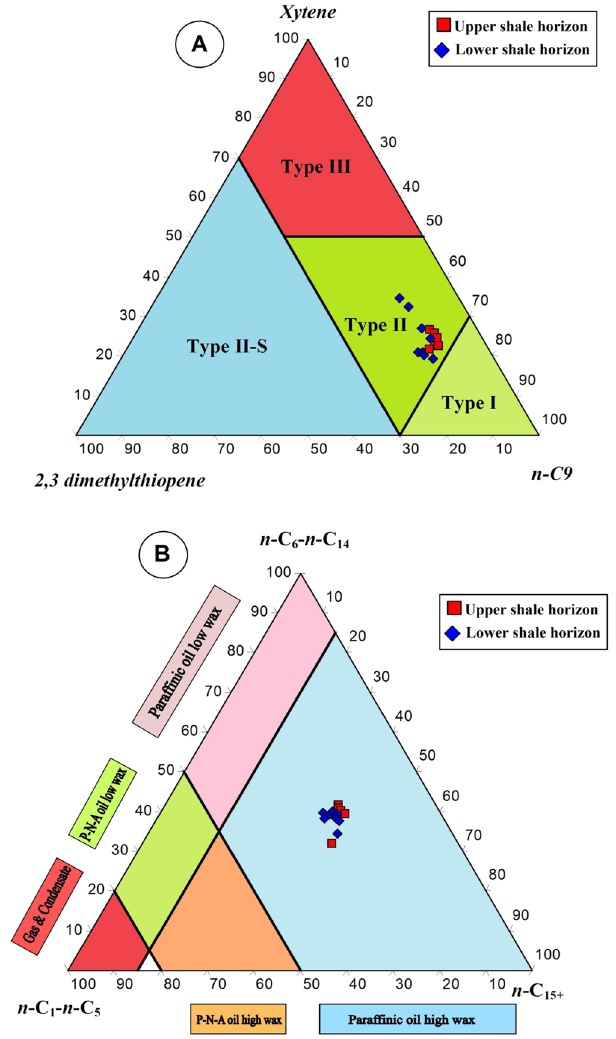
Figure 9. Ternary diagrams on the kerogen and petroleum type proxies derived from Py-GC data ( A ) distinguish the type of organic matter using relative percentage of compounds 2,3-dimethylthiophene, O-xylene (1,2- dimethylbenzene) and n-non-1-ene (n-C9:1), showing Type II kerogen (adapted after Eglinton et al. 36 ), and ( B ) ternary diagram after Horsfield 30 based on n-alkyl chain length distribution, showing that the analyzed shale samples are expected to generate a paraffinic high-wax oils. Tridraw 4.5 software is used to create this figure, https ://tridr aw.softw are.infor